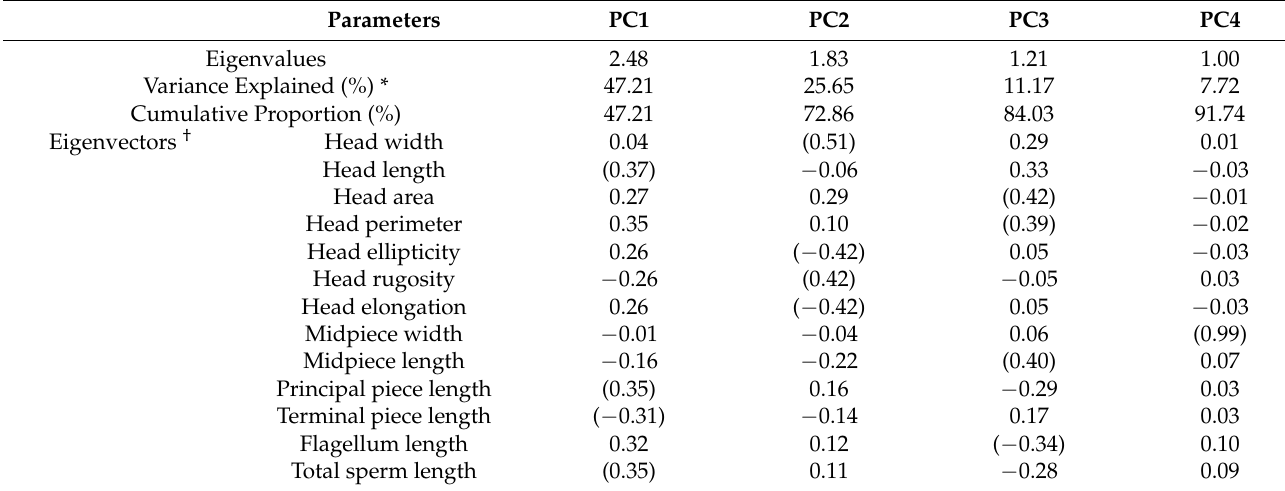
Table 3. Analysis of principal components (PCA) performed with bottlenose dolphin ( Tursiops truncatus ) sperm morphome- try data. Eigenvalues and variance explained in PC1, PC2, PC3 and PC4 and eigenvectors from the sperm morphometric variables distributed in four PCs. PC1 refers to sperm length; PC2 to shape of sperm head; PC3 to size of head, midpiece and flagellum; and PC4 refers to midpiece